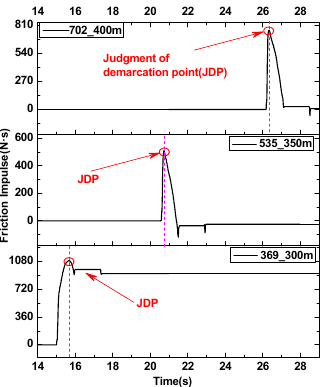
Figure 20. Friction impulse of wire rope.